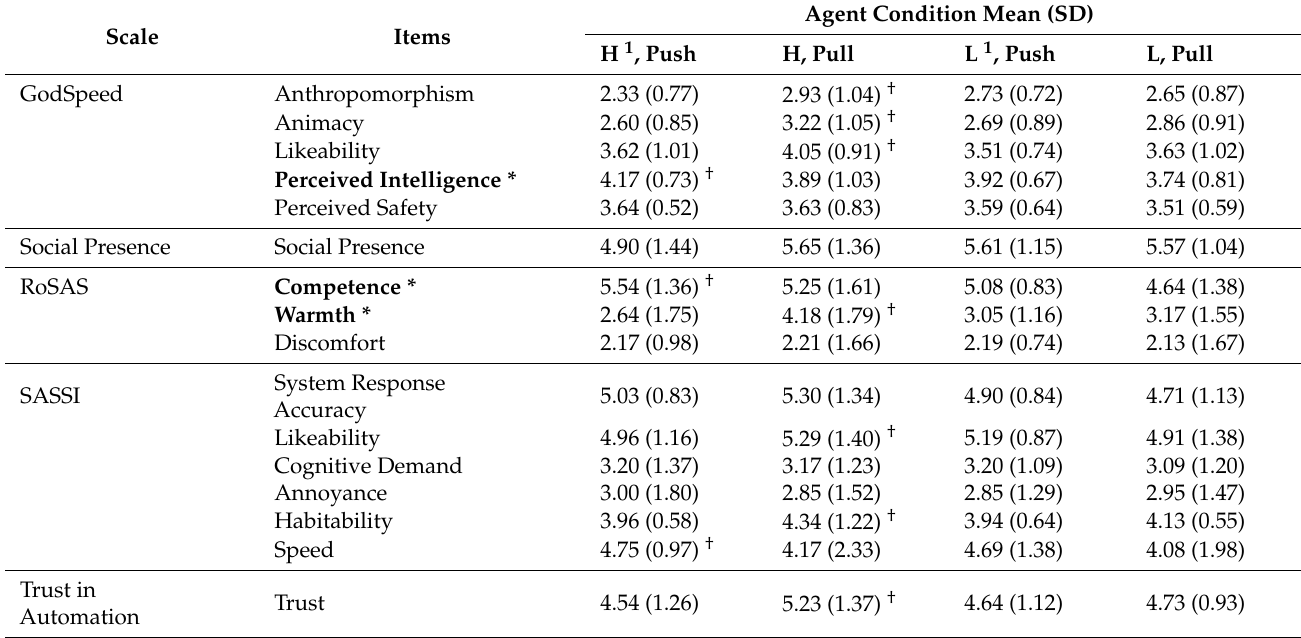
Table 4. Subjective evaluation results: condition means and standard deviation.